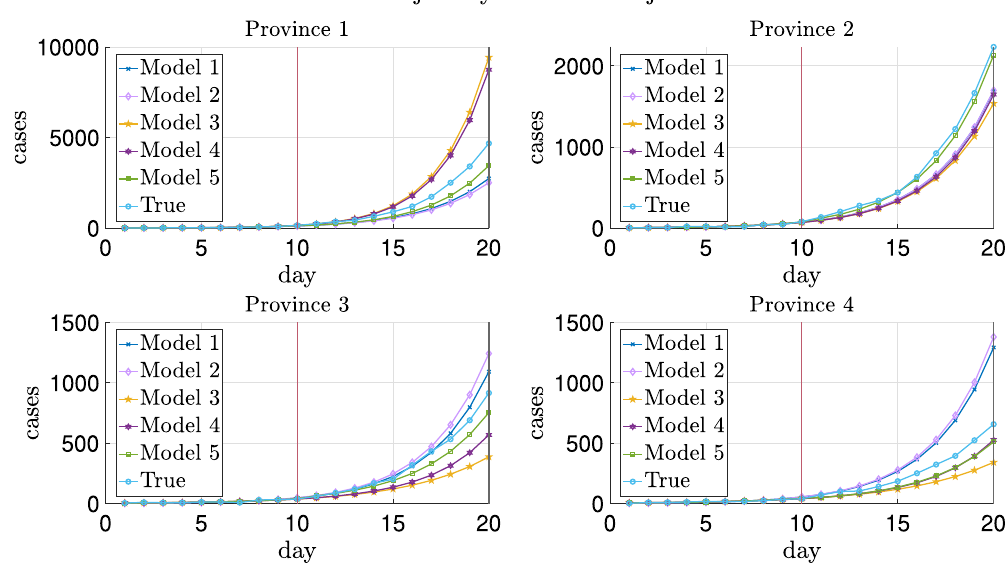
Figure 2. True and fitted trajectories for the simulated data with four provinces. The vertical lines show the threshold of training-testing split. In Model 5, µ = 10 2.7 is chosen, at which the averaged validation errors over 100 replicas are minimized as shown in Supplementary Figs. S2 and